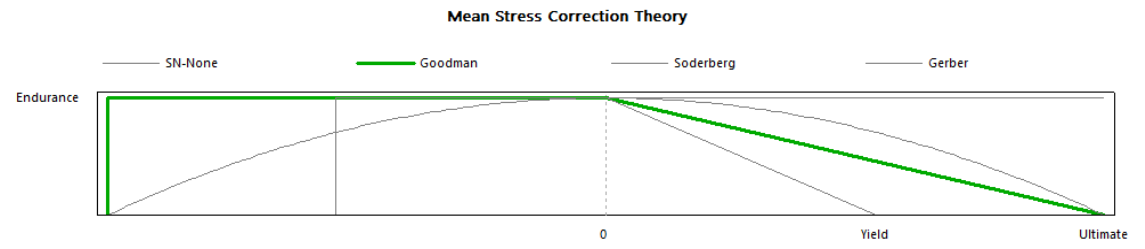
Figure 20. Load pattern constant.